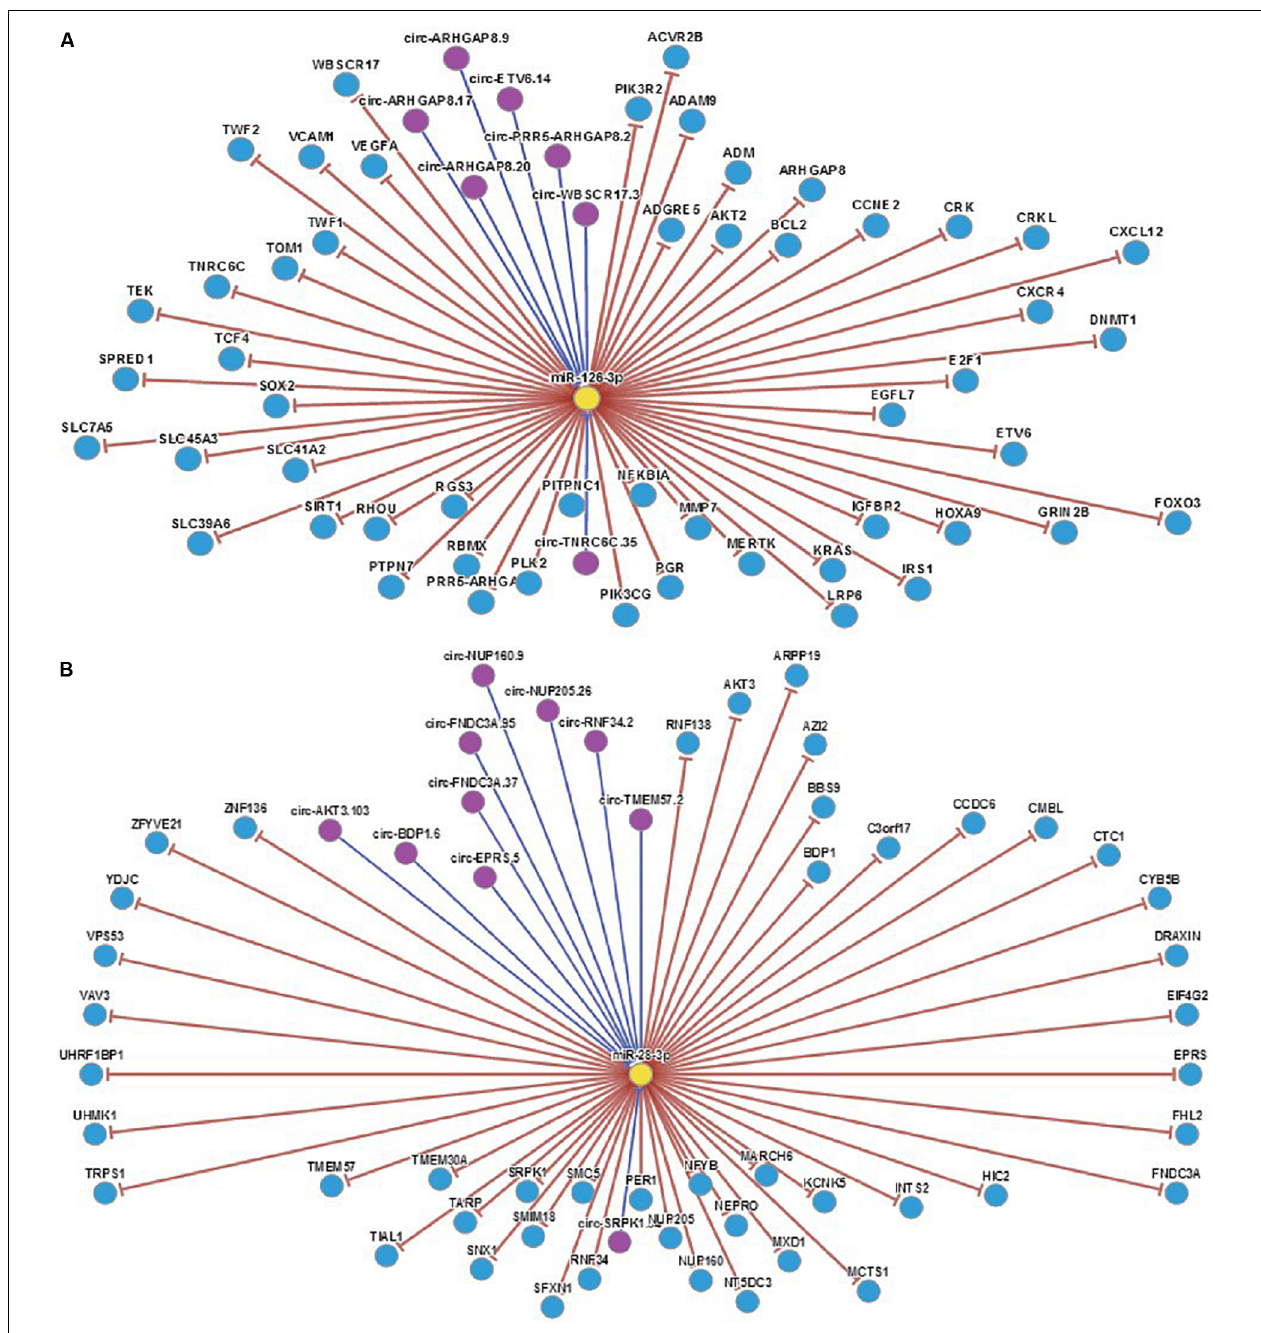
FIGURE 7 | (A) Regulatory map of miRNA-126 related genes. (B) Regulatory map of miRNA-28-3p and related